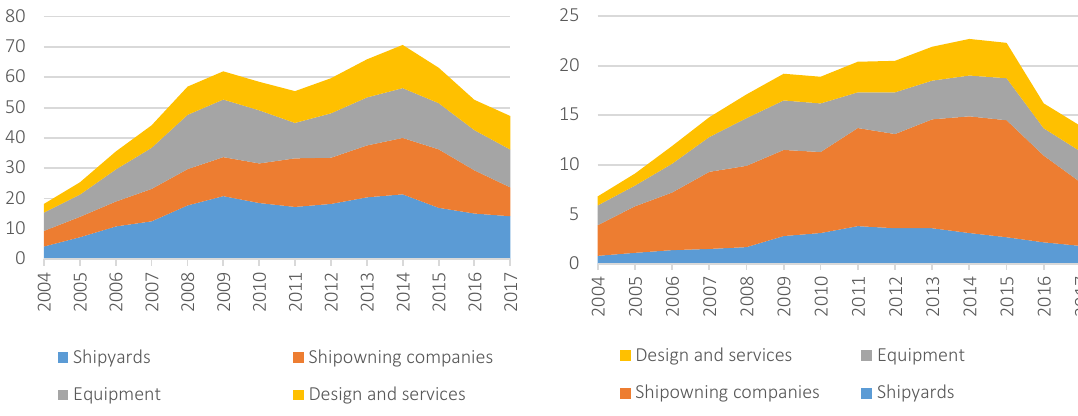
Figure 6. Turnover (left) and value added (right) in the BMC 2004–2017 in billion NOK